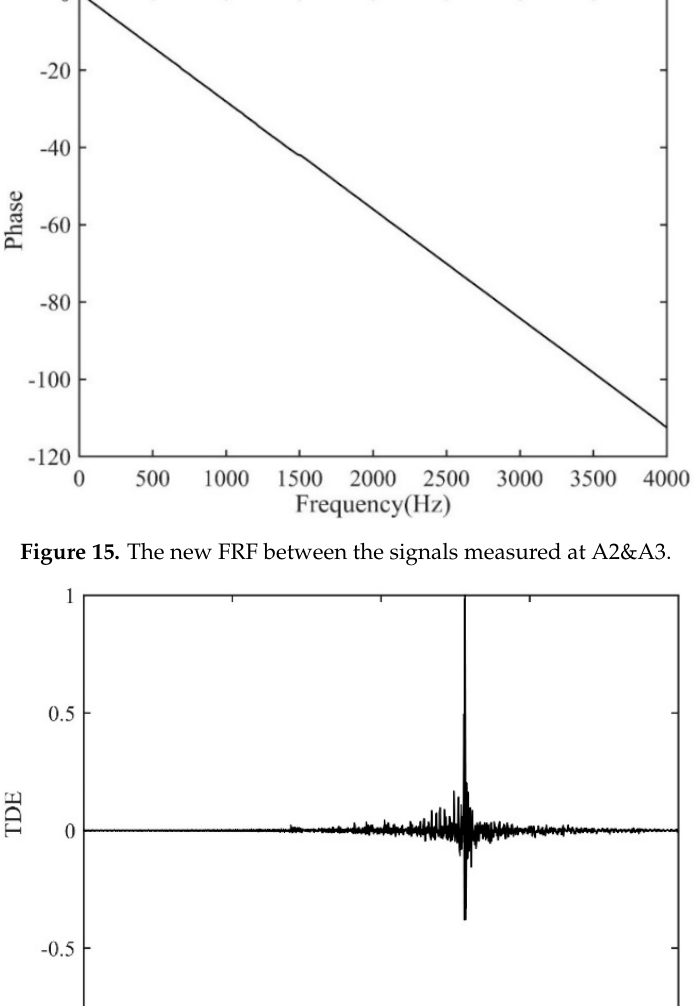
Figure 14. IRFs between the signals measured at A2&A3 using the conventional LMS adaptive method.